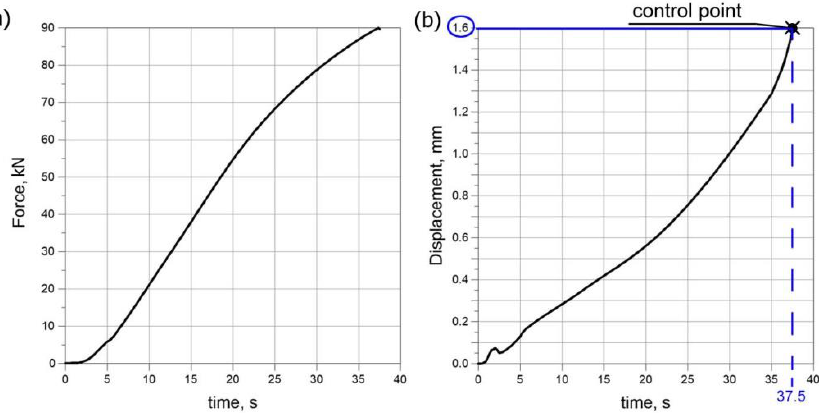
Figure 6. Characteristic parameters of the compression test, ( a ) load diagram, ( b ) displacement diagram of the upper traverse.